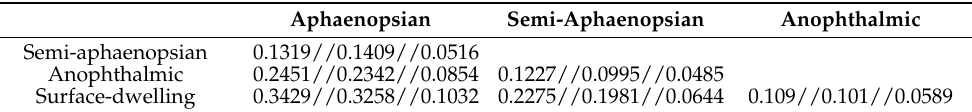
Table 2. Procrustes distances from four adaptive types of ground beetles based on the head, pronotum, and elytra, respectively.